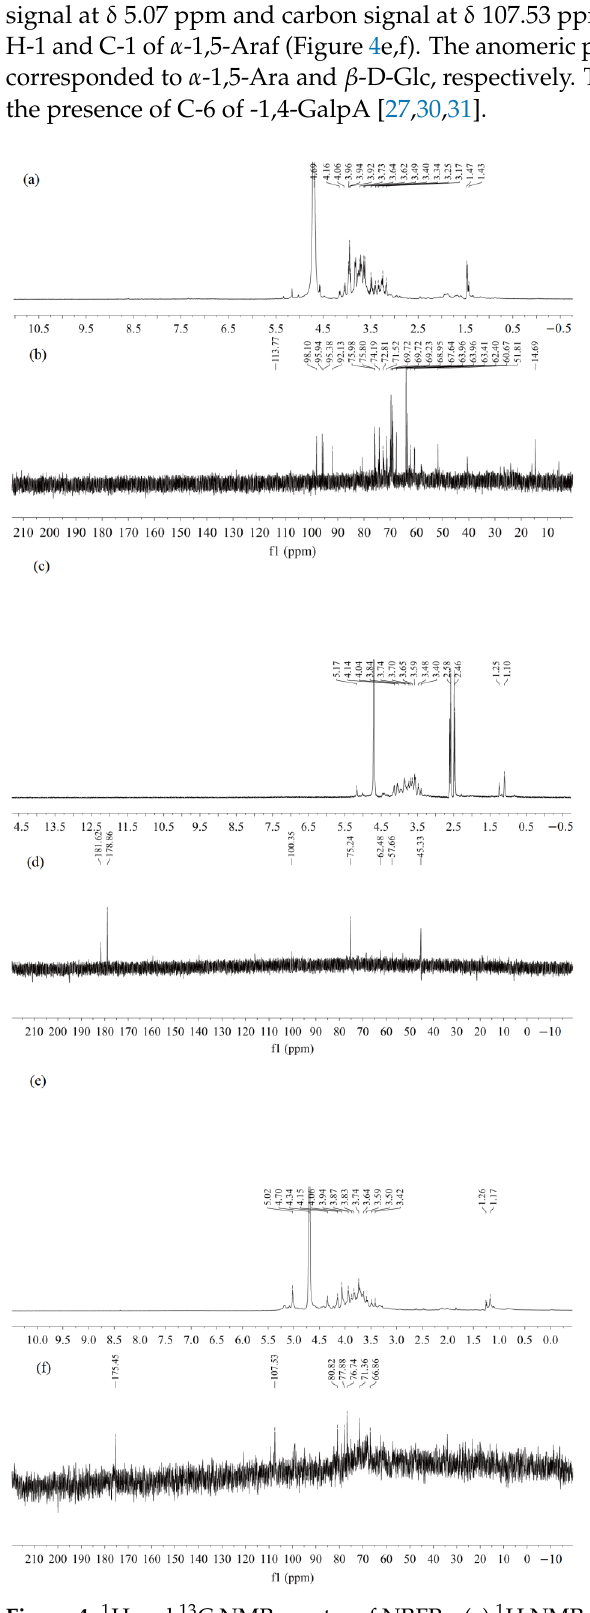
Figure 4. 1 H and 13 C NMR spectra of NRFPs. ( a ) 1 H NMR spectra of NRFP-1; ( b ) 13 C NMR spectra of NRFP-1; ( c ) 1 H NMR spectra of NRFP-2; ( d ) 13 C NMR spectra of NRFP-2; ( e ) 1 H NMR spectra of NRFP-3; ( f ) 13 C NMR spectra of